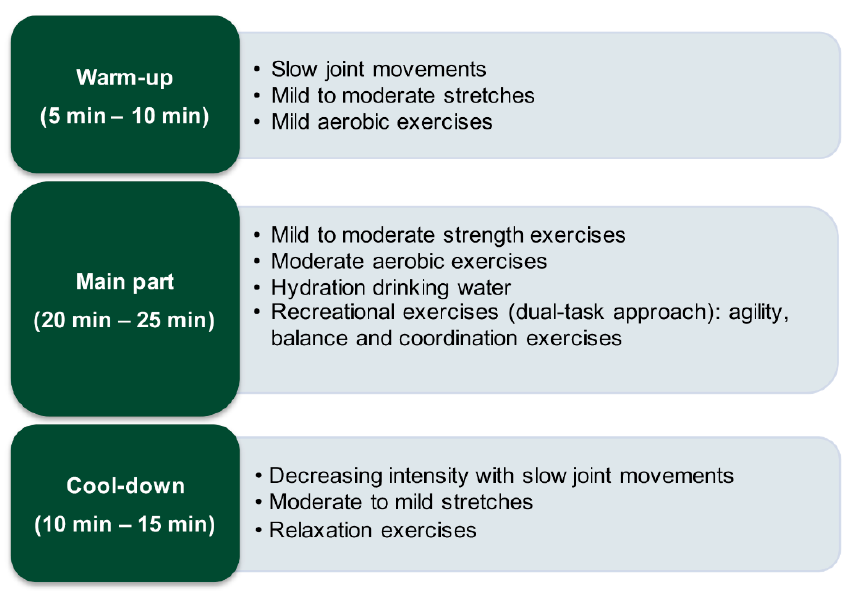
Figure 2. Structure of sessions in the multimodal physical exercise program (MPEP).